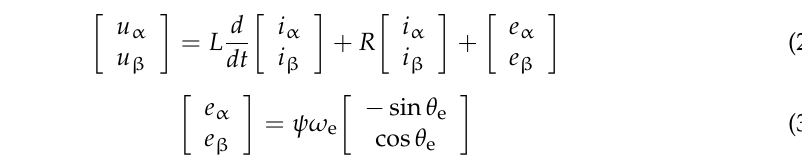
Figure 1. PMSM vector diagram under d-q coordinate and α - β coordinate. The voltage model of a PMSM motor in the d-q frame can be expressed as (cid:20) u d d where u d and u q are the stator voltages, i d and i q are the stator currents, p is the number of pole pairs, R and L are the equivalent resistance and inductance of the stator winding, ω e is the electrical angular velocity of the rotor, and ψ is the permanent magnet flux linkage. Then, the voltage model of the surface mounted PMSM in the α - β coordinate can be expressed as